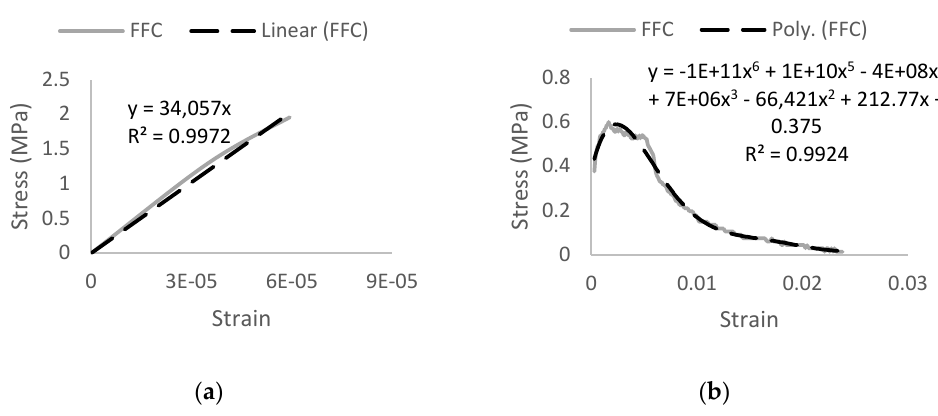
Figure 6. FFC uniaxial tension stress – strain curve: ( a ) elastic stage and ( b ) plastic stage. The compressive and tensile stress – strain curves of the developed FFC HyFRC were combined to form a constitutive model as shown in Figure 7a. In addition, the Concrete Damaged Plasticity (CDP) data collected from this model were used for verification in numerical analysis as presented in Table 7.